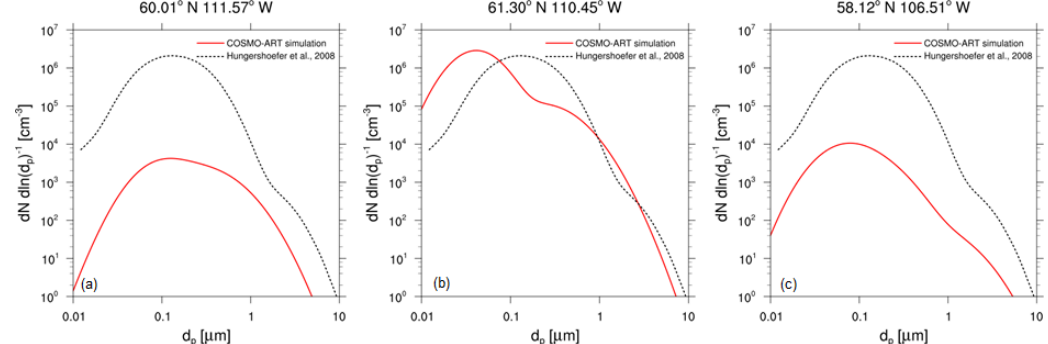
Figure 11. Number size distribution (a) at 60.01 ◦ N, 111.57 ◦ W (Fort Smith), (b) 61.30 ◦ N, 110.45 ◦ W (at fire), and (c) 58.12 ◦ N, 106.51 ◦ W (close to fire) near the surface on 15 July 2010 at 18:00UTC for VARHEIGHT (red line) and as comparison measurements from an experi- mental fire (doted black line) performed by Hungershoefer et al. (2008).